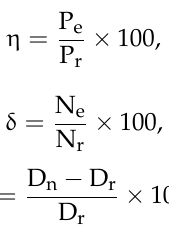
Table 3. Specification of the sensors constituting the field load measurement system. Item